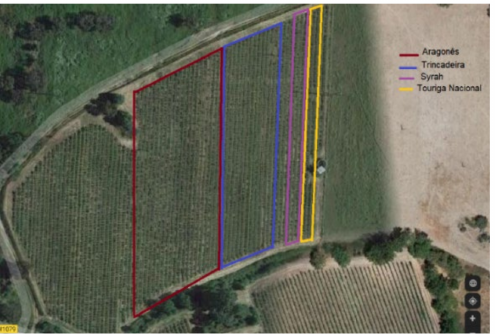
Figure 1. Herdade da Mitra Vineyard (38.533567, −